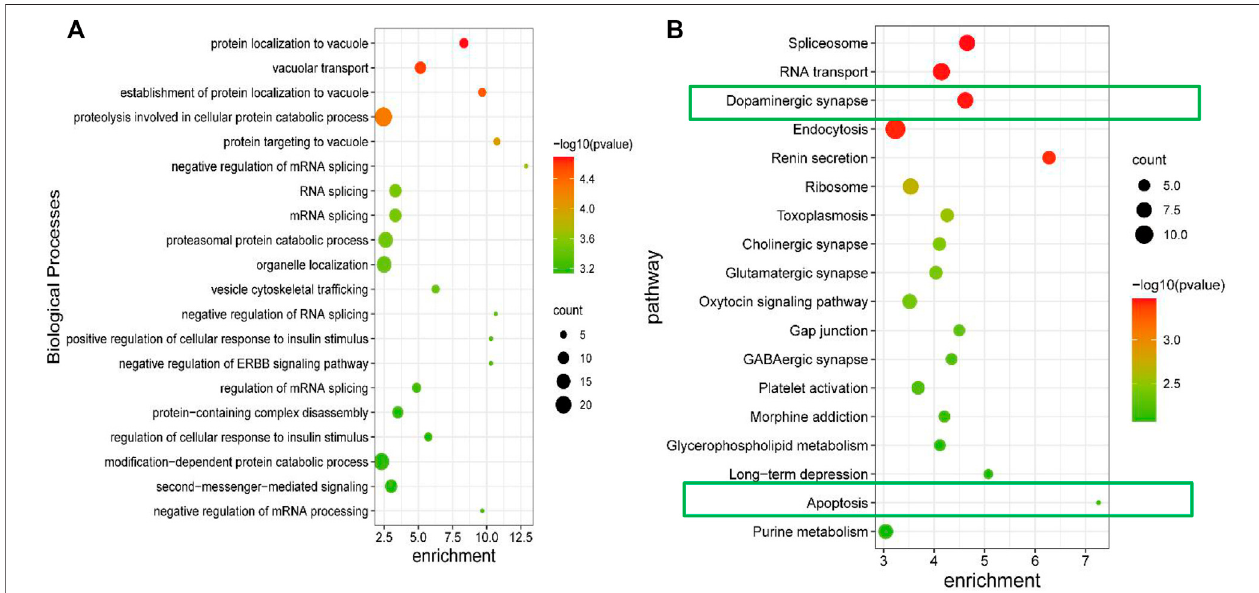
FIGURE 6 | GO enrichment and KEGG pathway analysis of differential expressed proteins. The biological process of differentially expressed proteins derived from the GO analysis (A) ; KEGG signaling pathway analysis for the differentially expressed proteins, the p -value was set at < 0.05 (B) .